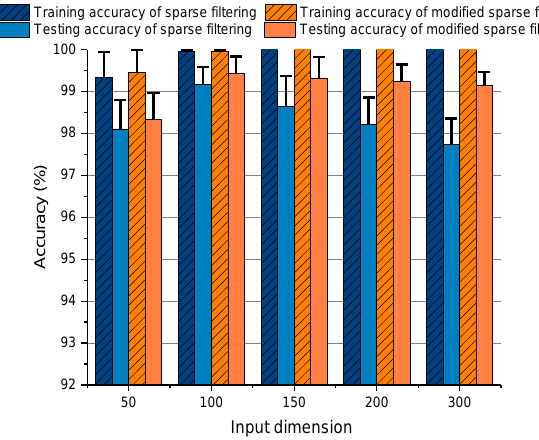
Figure 11. Diagnosis results using various input dimensions of modified and original sparse filtering.